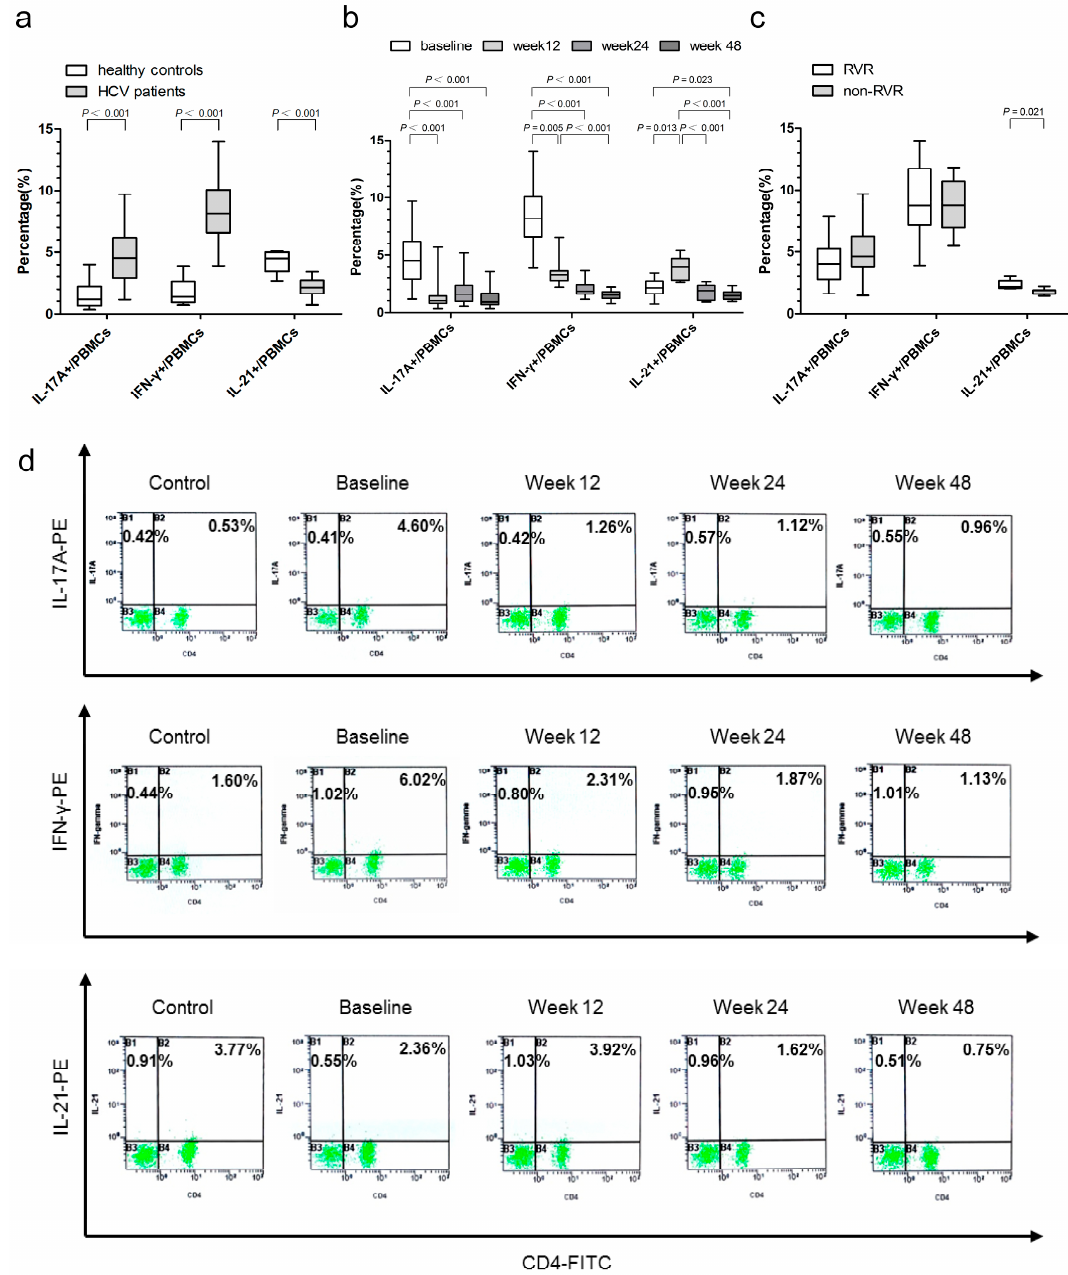
Figure 2. The proportion of IL-17A-, IFN- γ - and IL-21-producing peripheral blood mononuclear cells (PBMCs) were determined by flow cytometry in healthy controls and HCV-infected patients. ( a ) Baseline levels in HCV-infected patients ( n = 66) and healthy controls ( n = 20); ( b ) proportion in HCV-infected patients at baseline, 12, 24, and 48 weeks after antiviral therapy; ( c ) comparison of baseline proportion in HCV-infected patients who achieved RVR ( n = 39) and who had non-RVR ( n = 27). The length of the box represents the interquartile range. The horizontal line inside each box represents the median values; and ( d ) representative data of IL-17A-, IFN- γ -, and IL-21-producing PBMCs in healthy controls and HCV-infected patients at baseline and 12, 24, and 48 weeks after antiviral therapy. The percentages of CD4 + /IL-17A + , CD4 + /IFN- γ + , and CD4 + /IL-21 + PBMCs are shown on the right upper quadrant of each panel, and the percentages of CD4 − /IL-17A + , CD4 − /IFN- γ + , and CD4 − /IL-21 + PBMCs are shown on the left upper quadrant of each panel.